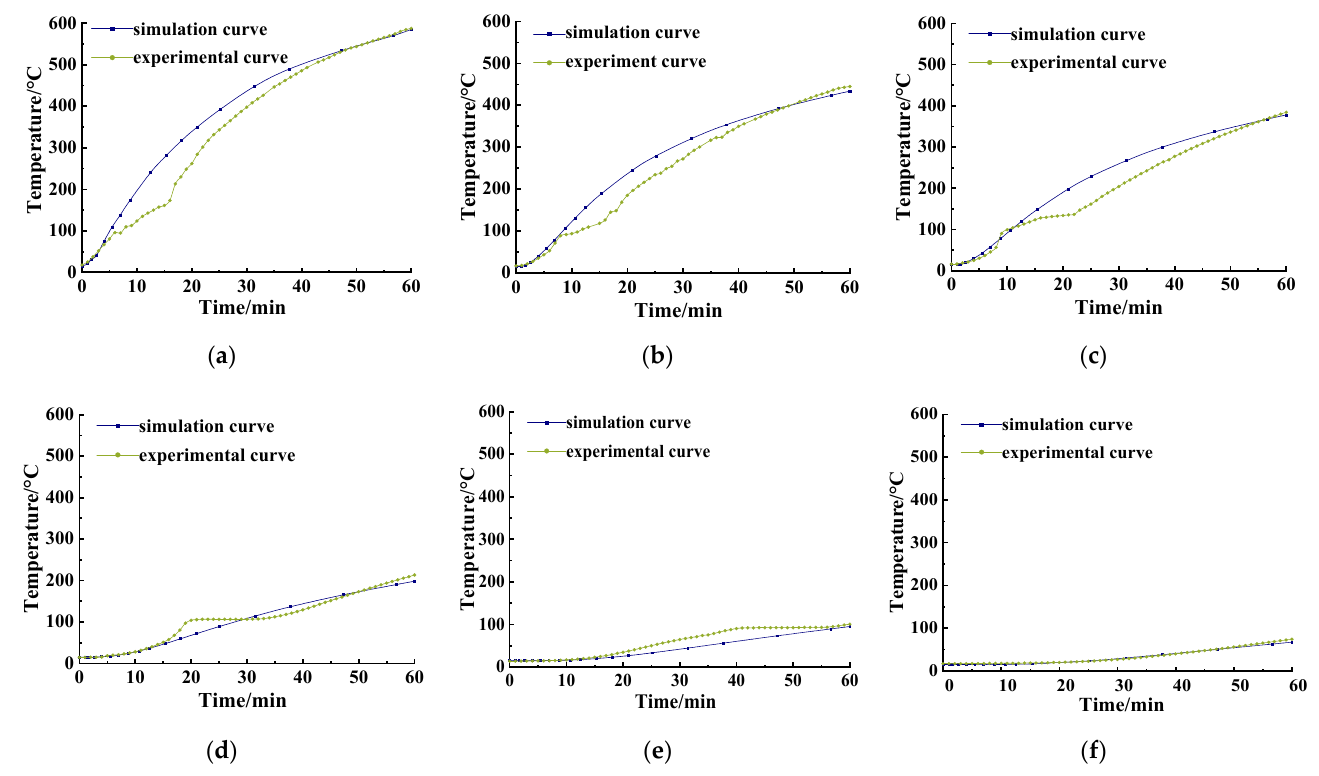
Figure 16. Temperature–time comparison curves at each section based on the λ SFRC simulation and